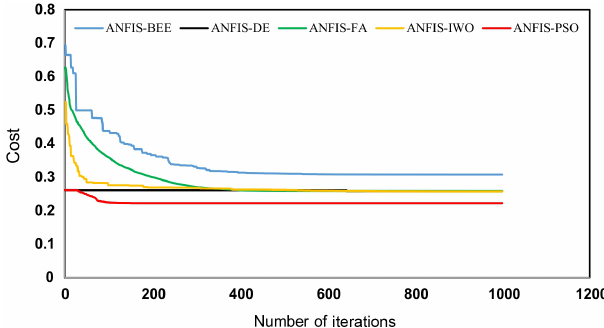
Figure 8. Convergence plot of the